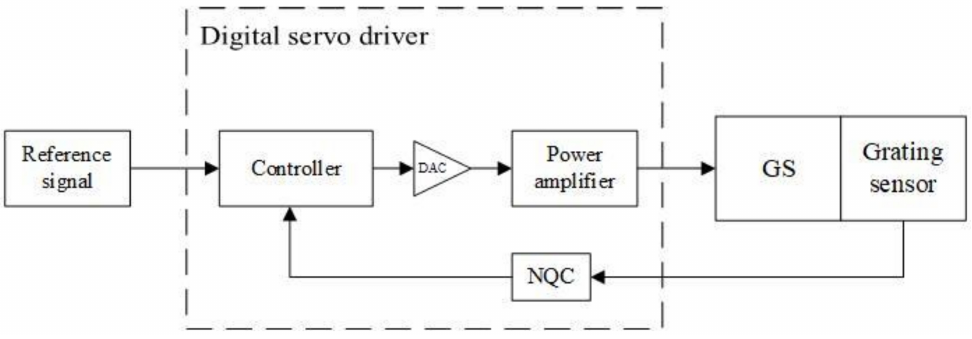
Figure 1. Compositions of the closed-loop control system of the